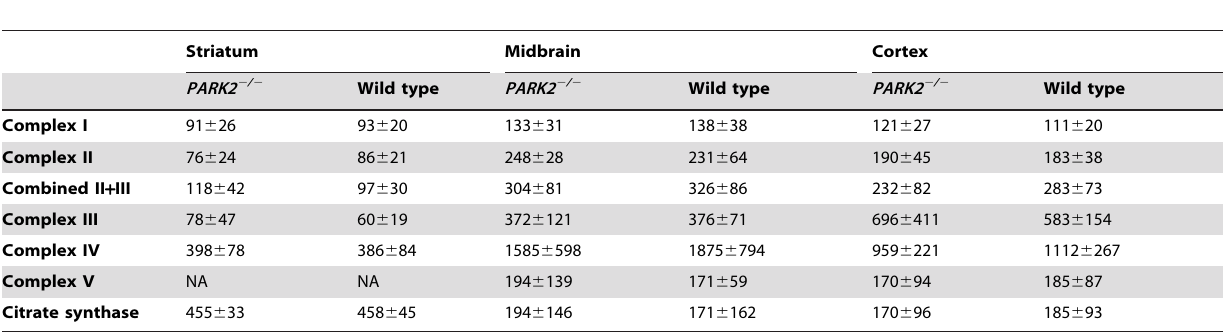
Table 1. Activities of mitochondrial respiratory chain complexes in 12-month-old PARK2 2 / 2 and wild type